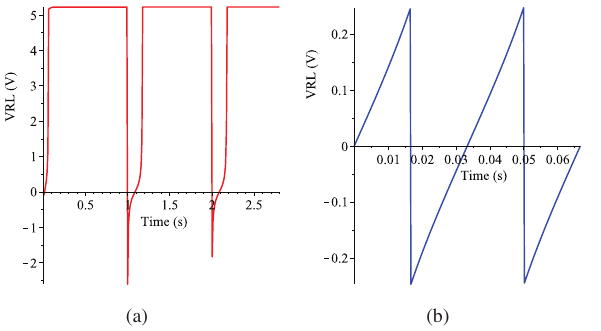
Fig. 6 : V RL dependent on t, supplied periodic square wave voltage source, V 0 = 10 V , x n ( t = 0 ) = 0 . 5 , (a) f = 0 . 5 Hz , (b) f = 30 Hz .